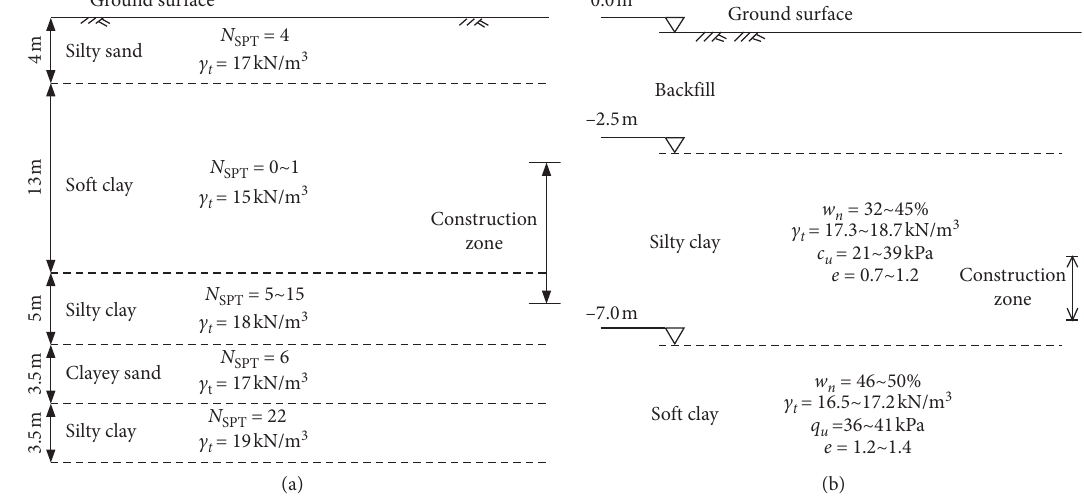
Figure 2: Geotechnical profile and soil conditions for two different cases: (a) case history conducted in soft clay (after [31]); note: c weight; N SPT � blow counts of the standard penetration test (SPT); (b) case history conducted in silty clay (after [8]); note: w n � water content; c t � unit weight; e � void ratio; q u � unconfined compressive